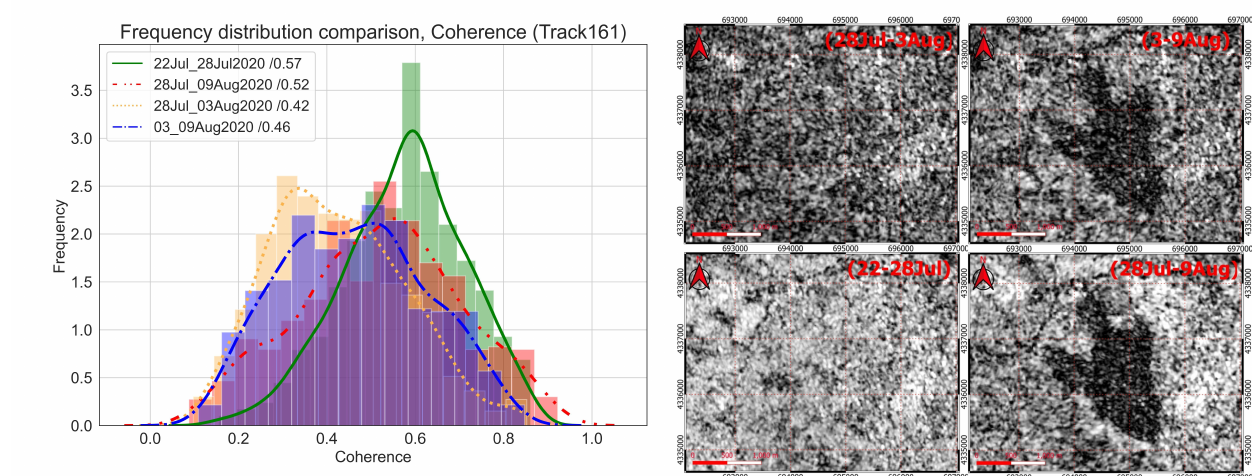
Figure 15. Effect of bad coherence: the cause is the acquisition of 3 August start at (17:28:15UTC, orbit 161) under bad weather conditions in the acquisition time according to precipitation site (WWO, 2021) (rainfall in daytime), compared to the acquisition of the same day but not the same time (05:37:58UTC for orbit 66).